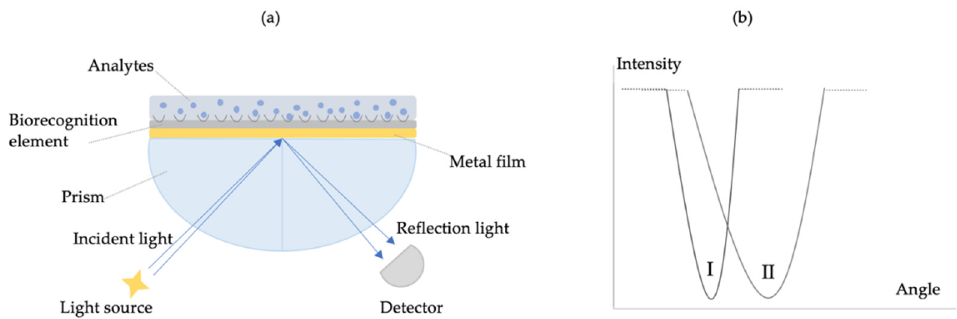
Figure 2. Scheme of plasmonic sensor with a metal and recognition layer ( a ) and change in the signal due to the increase of angle in the proximity of a sensor surface induced by captured target analytes ( b ).